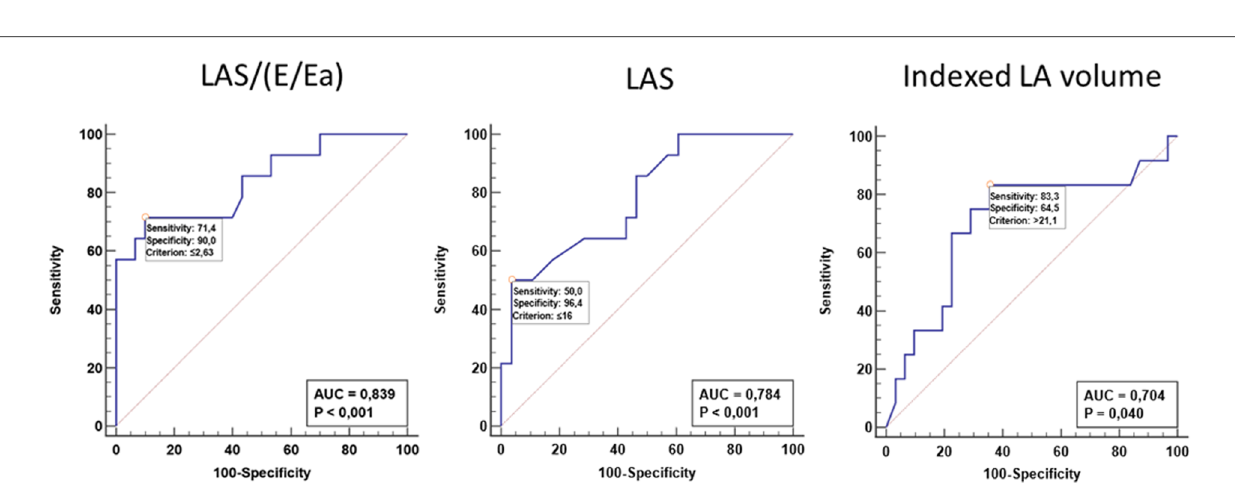
FIGURE 3 Receiver operating characteristic curves receiver operator characteristic (ROC) curve with the corresponding area under the curve (AUC) calculations to assess the ability to discriminate ToF patients with h-LTA. LA, left atrium; LAS, left atrial strain (reservoir